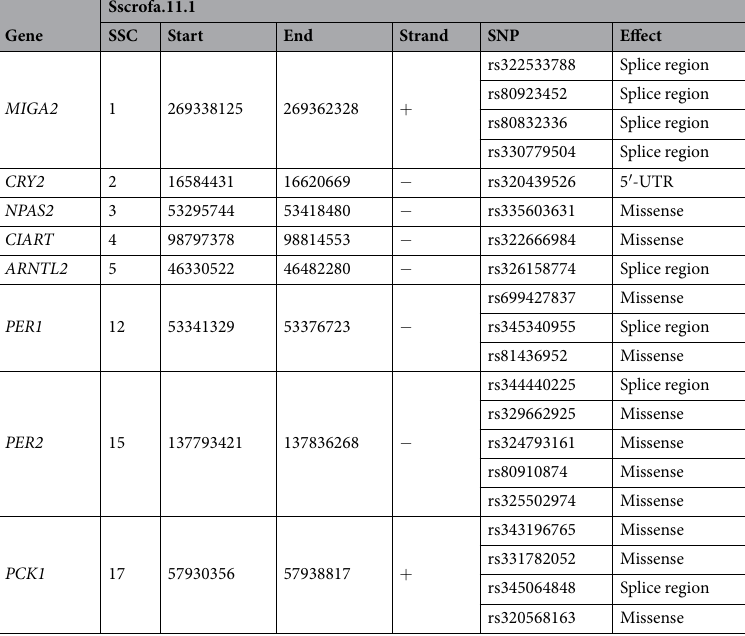
Table 1. List of polymorphisms genotyped in a population of Duroc pigs (N = 345). SSC: pig